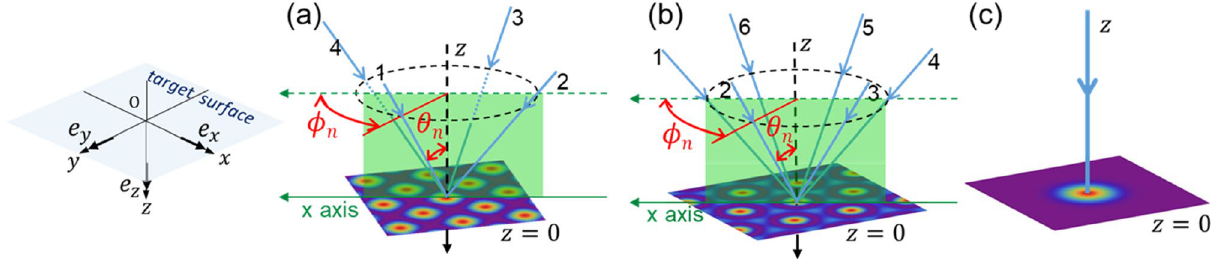
Figure 1. Scheme of light irradiation for ( a ) 4-beam interference, ( b ) 6-beam interference, and ( c ) a Gaussian beam. The left sketch shows the Cartesian system and unit